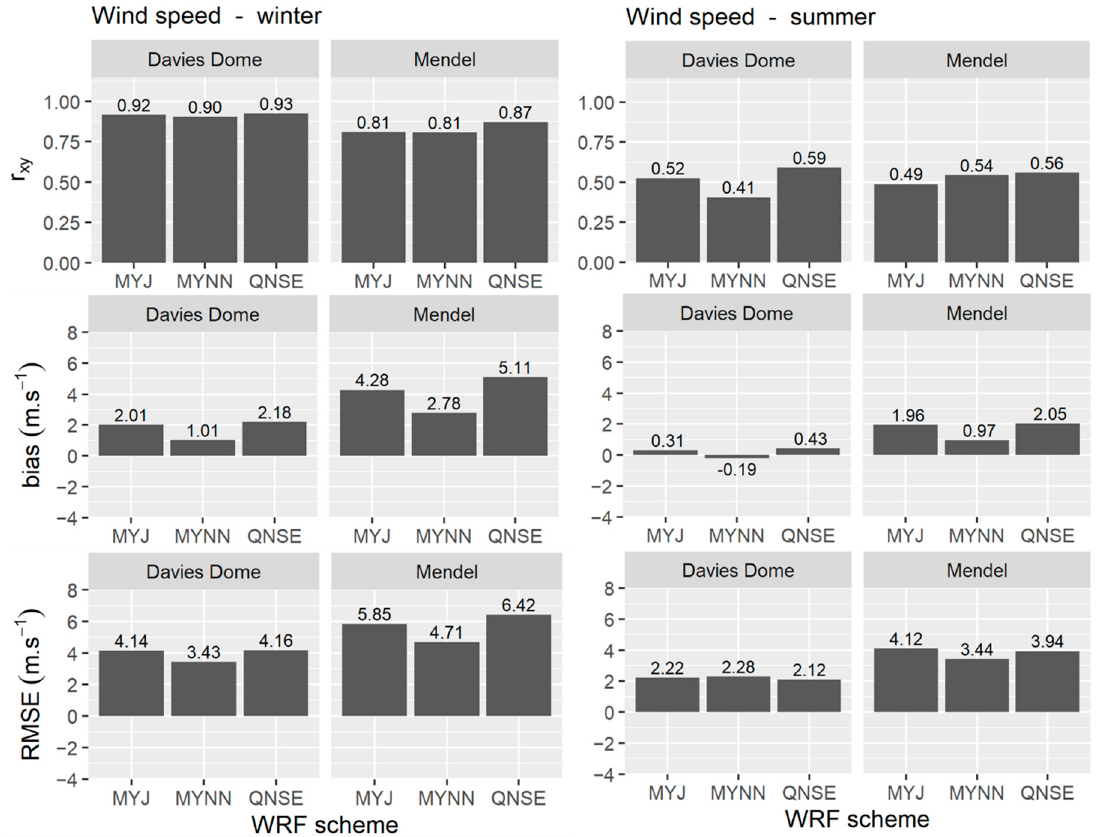
Figure 5. Validation statistics for modelled wind speed at selected automatic weather stations using three boundary layer schemes (MYJ, MYNN, QNSE) during the winter and summer periods.